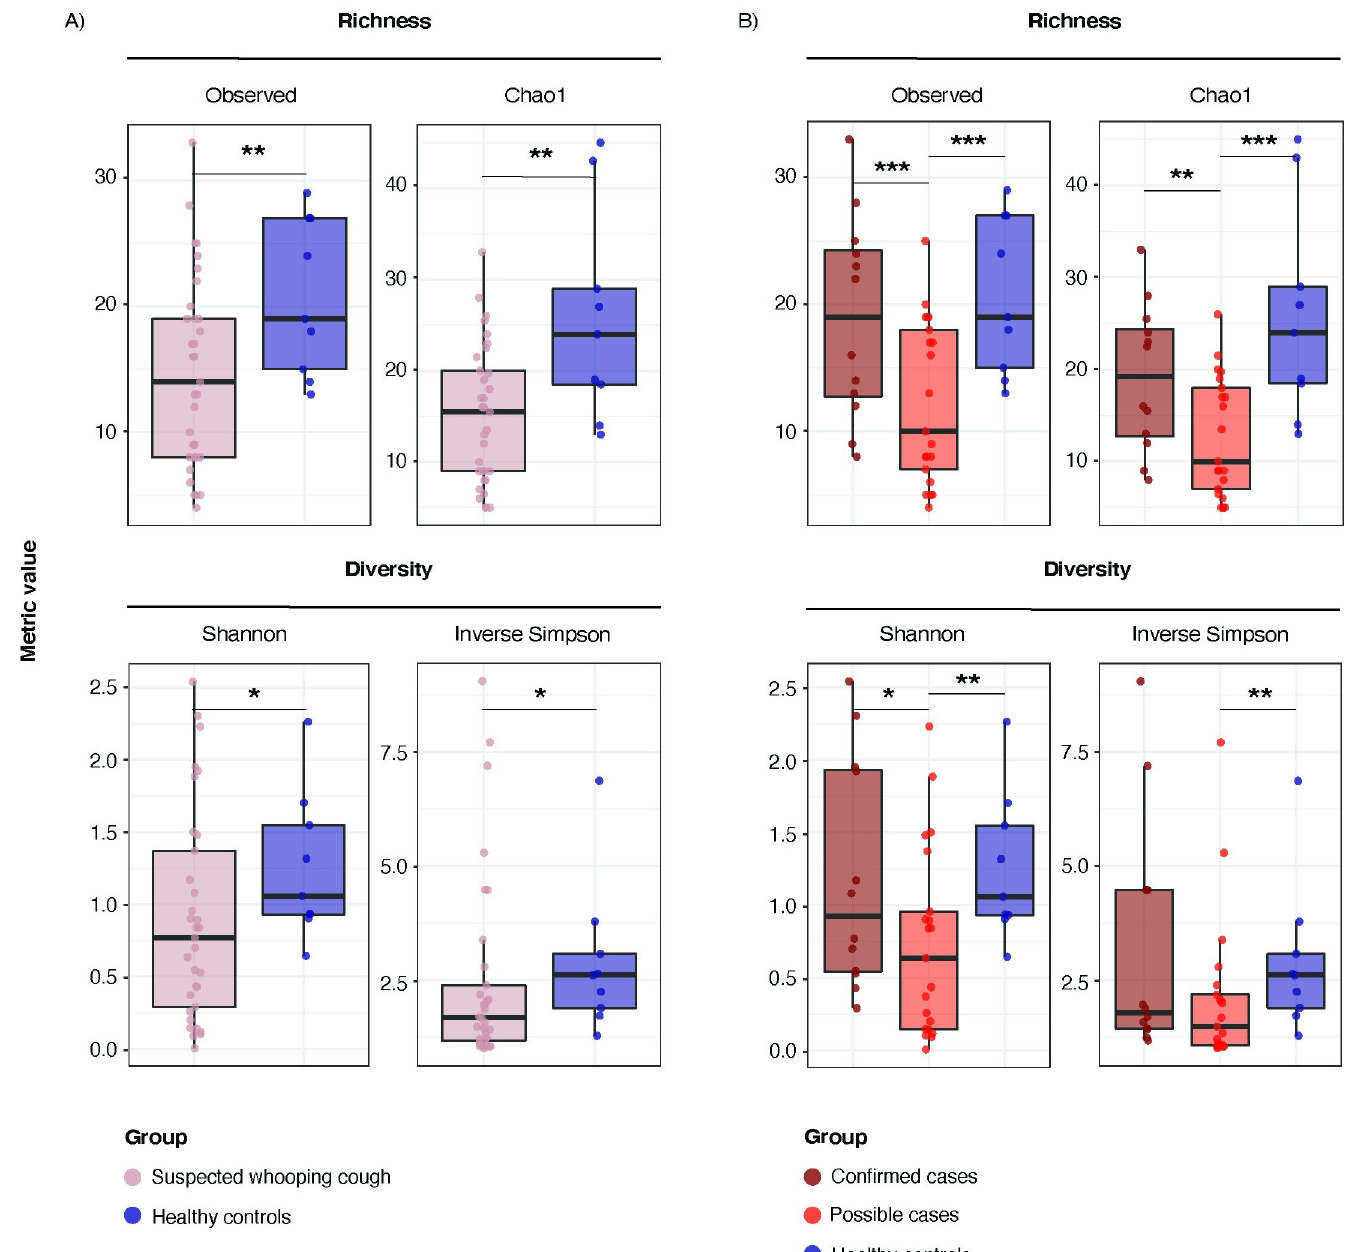
Fig 1. Alpha diversity metrics at the bacterial genus level between confirmed cases, possible cases and healthy controls. A) Boxplots showing the richness (Observed and Chao1 metric) and diversity (Shannon and Inverse Simpson indices) between the suspected whooping cough group (including confirmed and possible cases) and the healthy controls. B) Boxplots showing the richness and diversity between the confirmed cases, possible cases and the healthy controls. For both, A) and B), significance threshold is set as � p-value < 0.1, �� p-value < 0.05, ��� p -value < 0.01. fourth more abundant genera in healthy controls and possible cases while their mean abun- dance was lower in the confirmed cases (Fig 2A). Compared to healthy controls, suspected whooping cough was associated to higher Borde- tella and Moraxella as well as lower Corynebacterium , Neisseria , Actinomyces , Rothia and